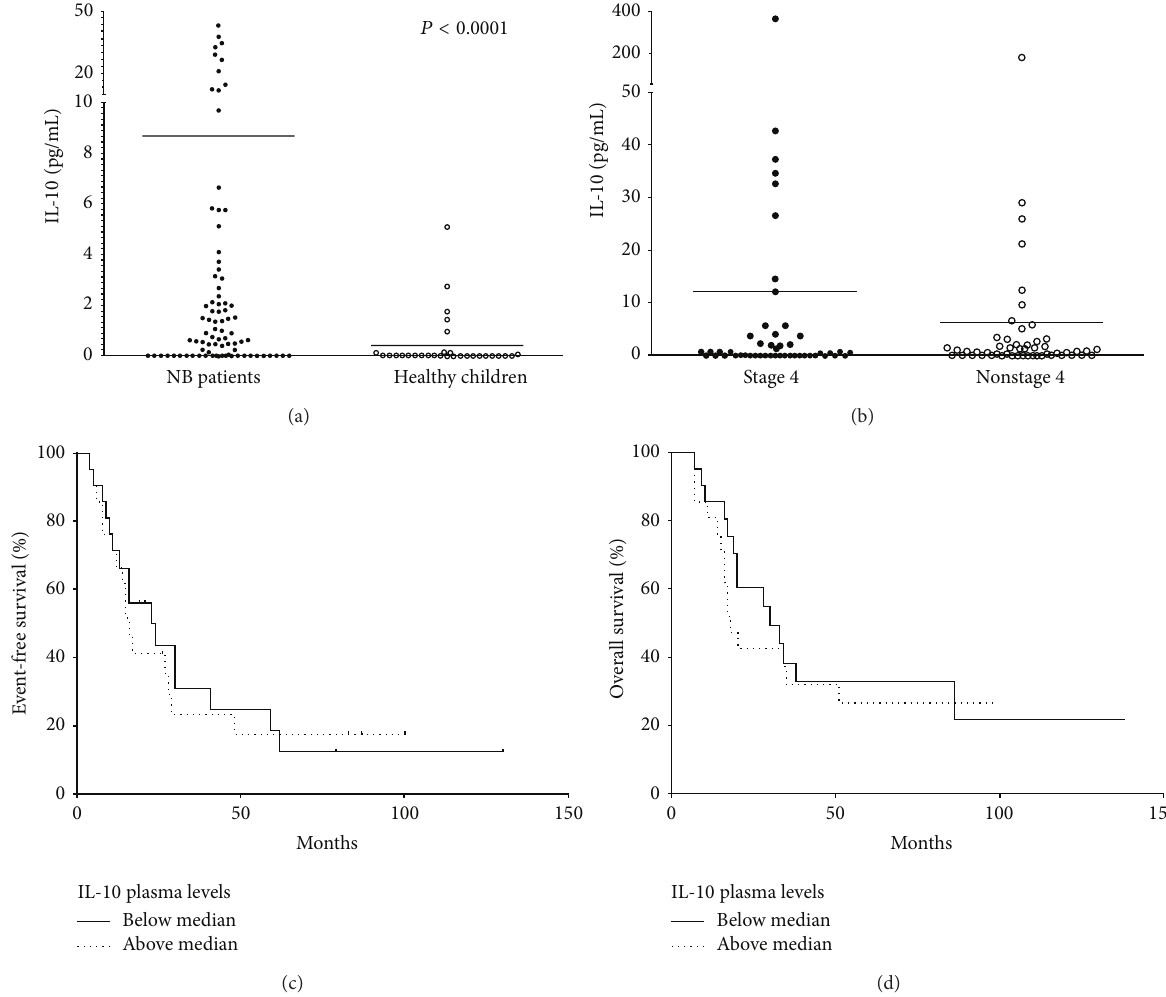
Figure 3: IL-10 plasma concentration in 102NB patients and 55 healthy children (a, b) and association between IL-10 plasma levels of stage 4 patients with EFS and OS (c, d). In (a), all NB patients and controls are shown. In (b), NB patients are stratified in stage 4 ( 𝑛 ∘ = 50 ) and non-stage 4 ( 𝑛 ∘ = 52 ). Results are expressed as pg/mL. Horizontal bars indicate means. 𝑃 values are indicated where differences are significant. Kaplan-Meyer plot of EFS (c) and OS (d) obtained by stratifying the 50 stage 4NB patients according to IL-10 plasma levels above (dotted line) or below (continuous line) median value. 𝑌 -axes represent % of event-free or alive patients, respectively. 𝑋 -axes represent time of survival